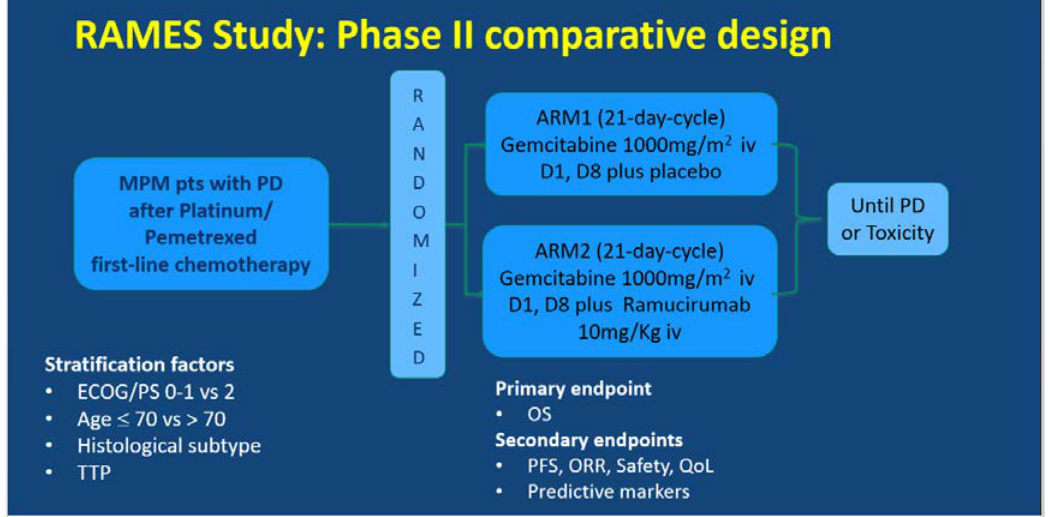
Figure 1. Ramucirumab Mesothelioma clinical trial (RAMES) study design. MPM, malignant pleural mesothelioma, PD, progressive disease, TTP, time to progression, OS, overall survival, PFS, progression-free survival, ORR, overall response rate, QoL, quality of